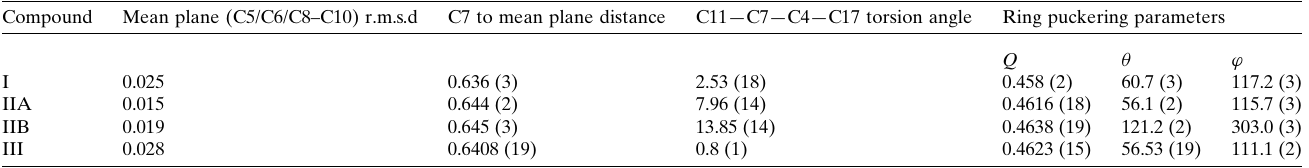
Table 2 Parameters (A˚ , (cid:2) ) related to the envelope conformation on the cyclohexanone ring. Compound